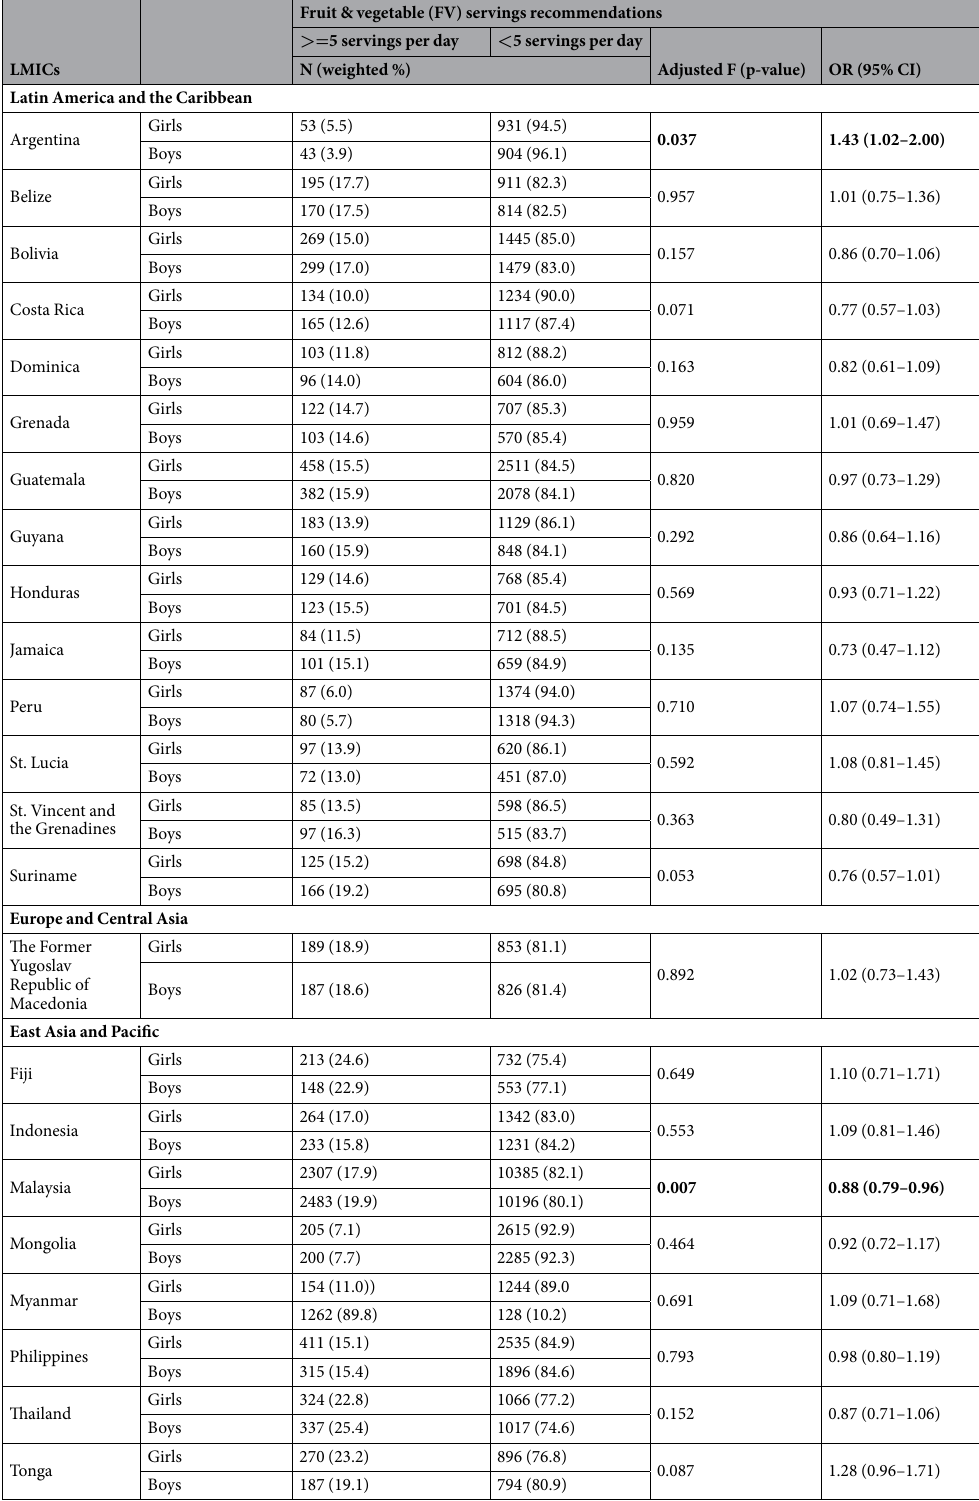
Table 2. Differences in the recommended daily fruit and vegetable intake among adolescent girls and boys in Low-and Middle-Income Countries from the Global School-based Student Health Survey (2004–2013) (N = 163,123 adolescents from 49 LMICs). OR = Odds Ratio; CI = Confidence Interval; Boldface value are significant at P < 0.05; - no data